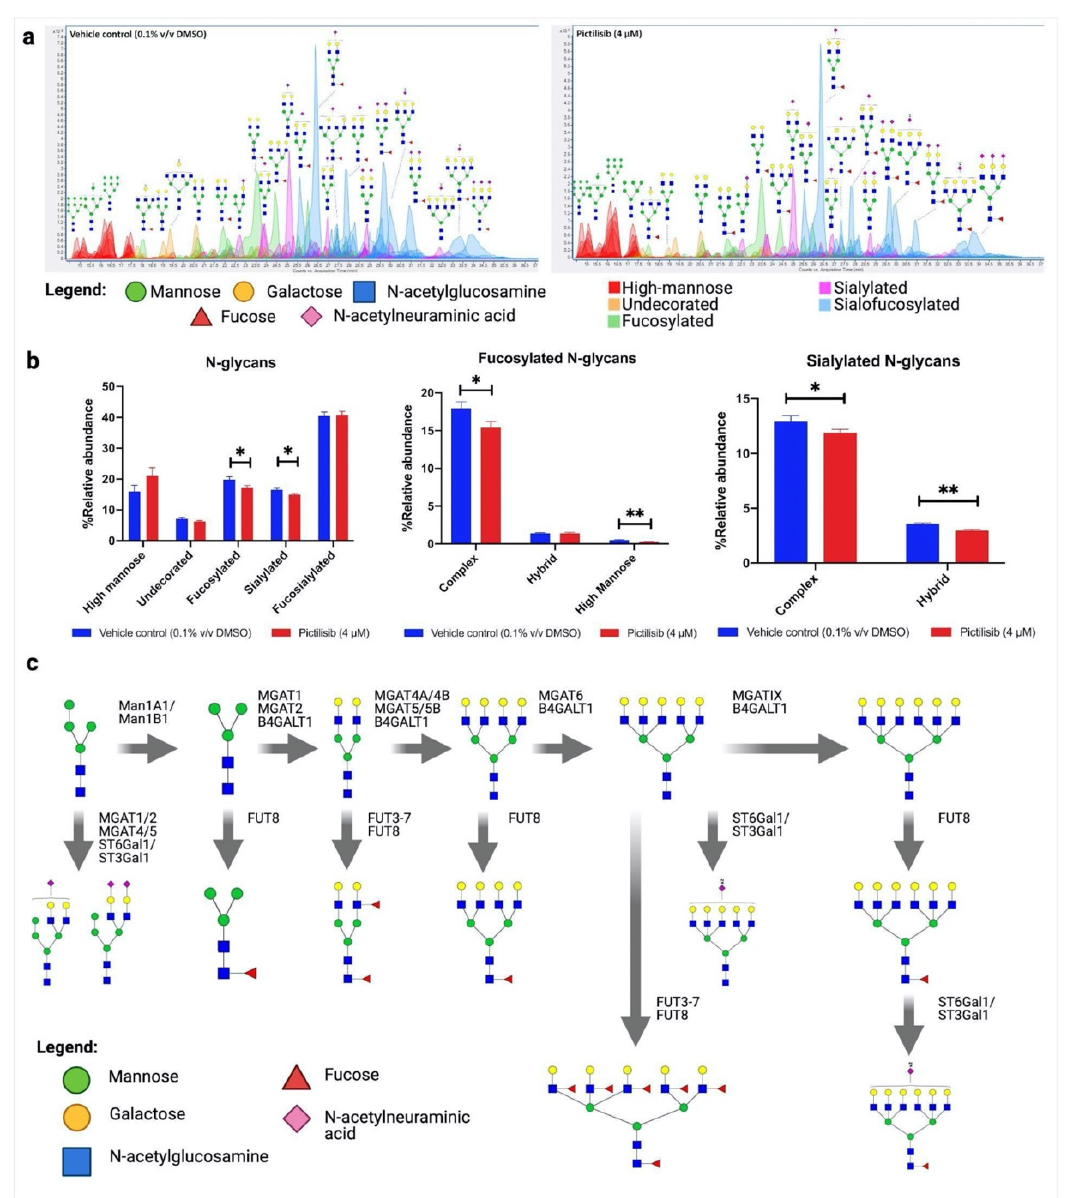
Figure 1. Pictilisib significantly reduced the relative abundance of fucosylated and sialylated N- glycans. ( a ) Glycan-annotated extracted ion chromatograms (EICs) of N-glycomes of vehicle control and pictilisib-treated A549 cells; ( b ) Relative abundances of N-glycan types in vehicle control and pictilisib-treated A549 cells; ( c ) Biosynthetic map showing the abundance of each significantly dif- ferent N-glycan (Table 1), N-glycan precursor, and known enzymes catalyzing the glycosylation reaction. The data represent mean ± SD; n = 3. The statistical differences were detected utilizing multiple t -test with FDR correction, * q < 0.05; ** q < 0.01.